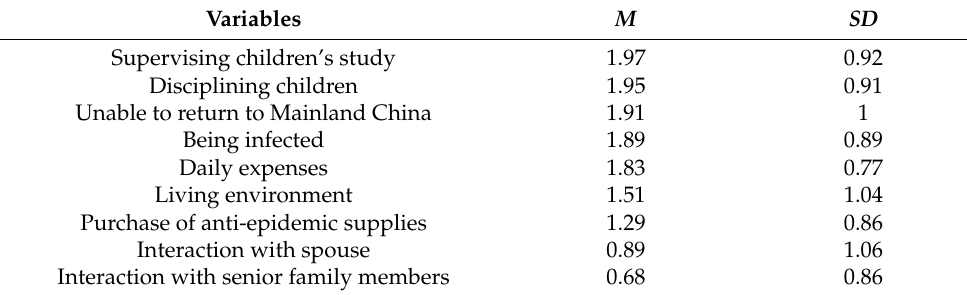
Table 3. Common Pandemic-related Stressors.